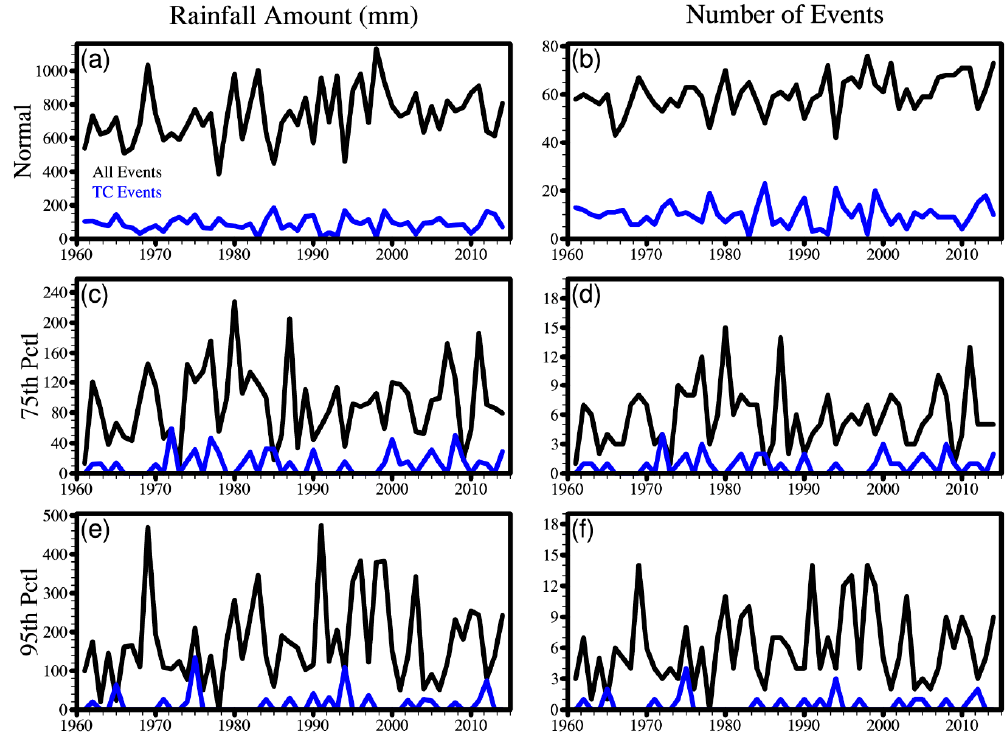
Figure 1. ( a ) Time series of the amount of total and TC-induced normal rainfall events over the middle–lower reaches of the Yangtze River (MLYRB) during summer. ( b ) Time series of the number of total and TC-induced normal rainfall events. ( c ) and ( d ) are the same as ( a ) and ( b ), but for 75th percentile precipitation events. ( e ) and ( f ) are the same as ( a ) and ( b ), but for 95th percentile precipitation events.